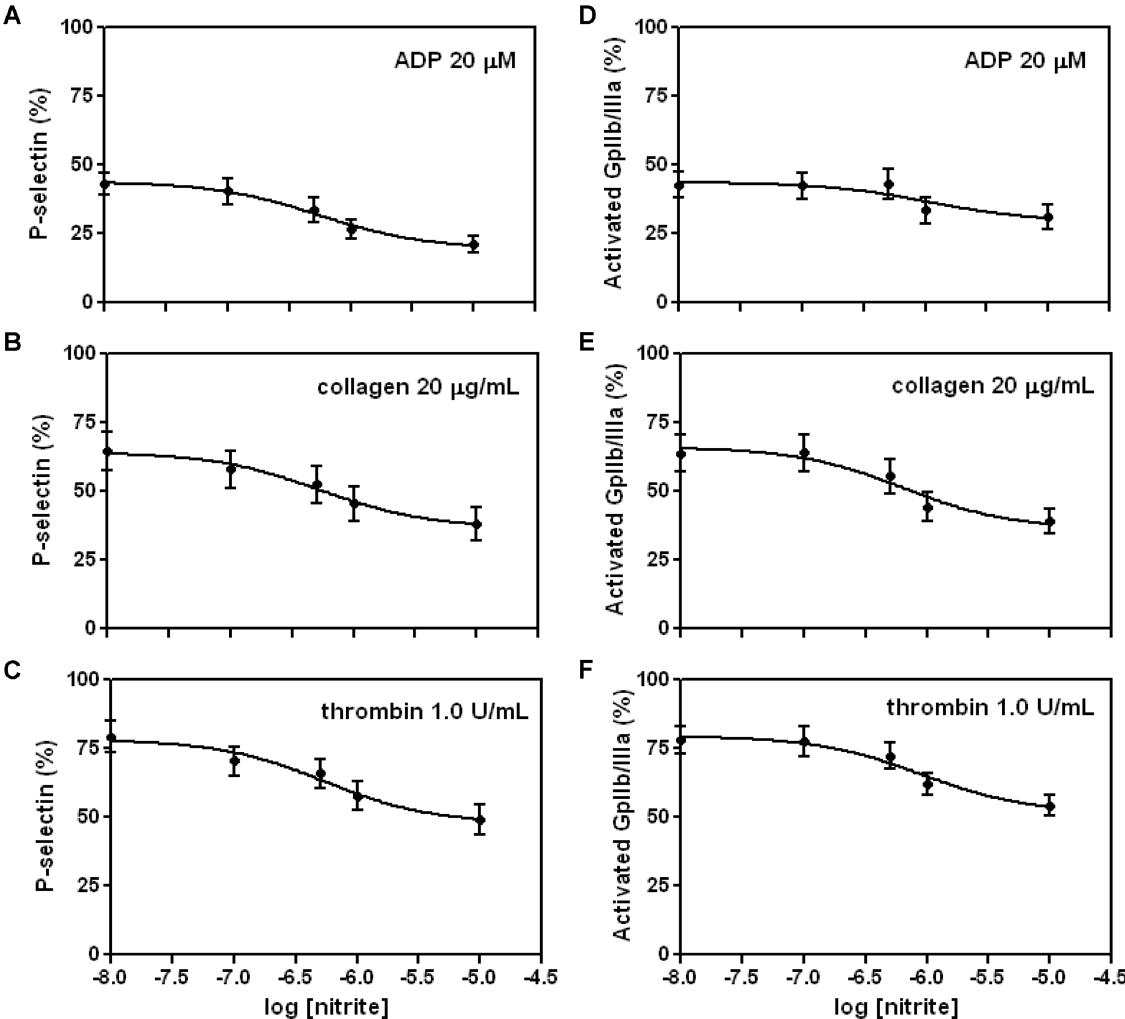
Figure 2. Effect of nitrite on platelet activation in platelet-rich plasma + erythrocytes. Platelet-rich plasma + erythrocytes were preincubated with nitrite (1 m M) at 37 u C for 5 minutes and platelet activation was induced by ADP (A, D, 20 m M), collagen (B, D, 20 m g/mL) and thrombin (C, F, 1 U/mL). P-selectin (A, B, C) and activated gpIIb/IIIa expression (D, E, F) was monitored. (CD62P and PAC-1, respectively, mean Hct 40%, mean pO 2 49 mmHg, n=6).